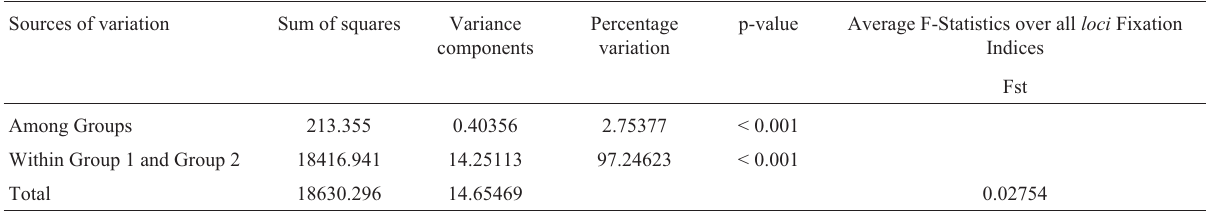
Table3 -Analysisofvarianceconsideringthebasecollectionof500accessionsandthecorecollectioncontaining180accessions(Group1-Basecollec- tion and Group 2 -Core Collection). Sources of variation Sum of